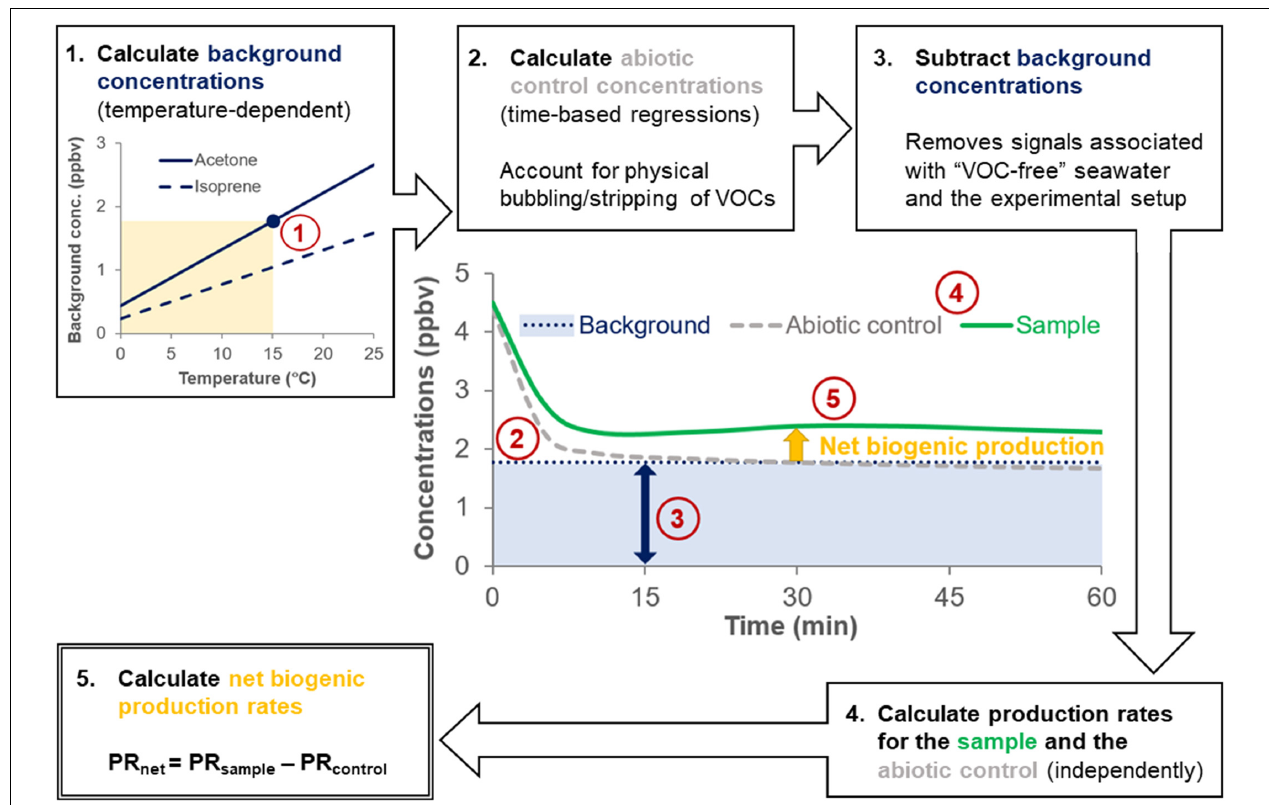
FIGURE 2 | Flow chart showing the calculation steps to obtain net VOC production rates. The flowchart is illustrated with hypothetical data. For example, in step 1, a background acetone concentration of 1.77 ppbv was calculated for a surface seawater sample collected at 15 ◦ C (yellow shading). Temperature-dependent background concentrations determined from measurements of autoclaved and bubbled (“VOC-free”) artificial seawater (blue line) are subtracted from sample concentrations (green line) and abiotic control concentrations (gray line) to account for signals arising from the experimental setup. VOC production rates from abiotic controls are subtracted from the sample VOC production rates to account for the physical removal (“stripping”) of VOCs caused by bubbling, yielding the net biogenic production rate (yellow arrow).